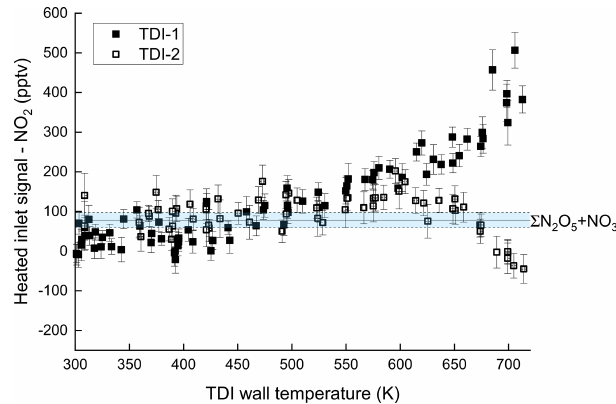
Figure 4. Temperature-dependent NO 2 detection when sampling 2.75ppbv NO 2 and 146ppbv O 3 in 23SLPM dry synthetic air from SCHARK through TDI-1 and TDI-2. The signal from the NO 2 cav- ity (no TDI) has been subtracted from both datasets. The mixing ratios of N 2 O 5 + NO 3 (with associated uncertainty) are indicated by the blue